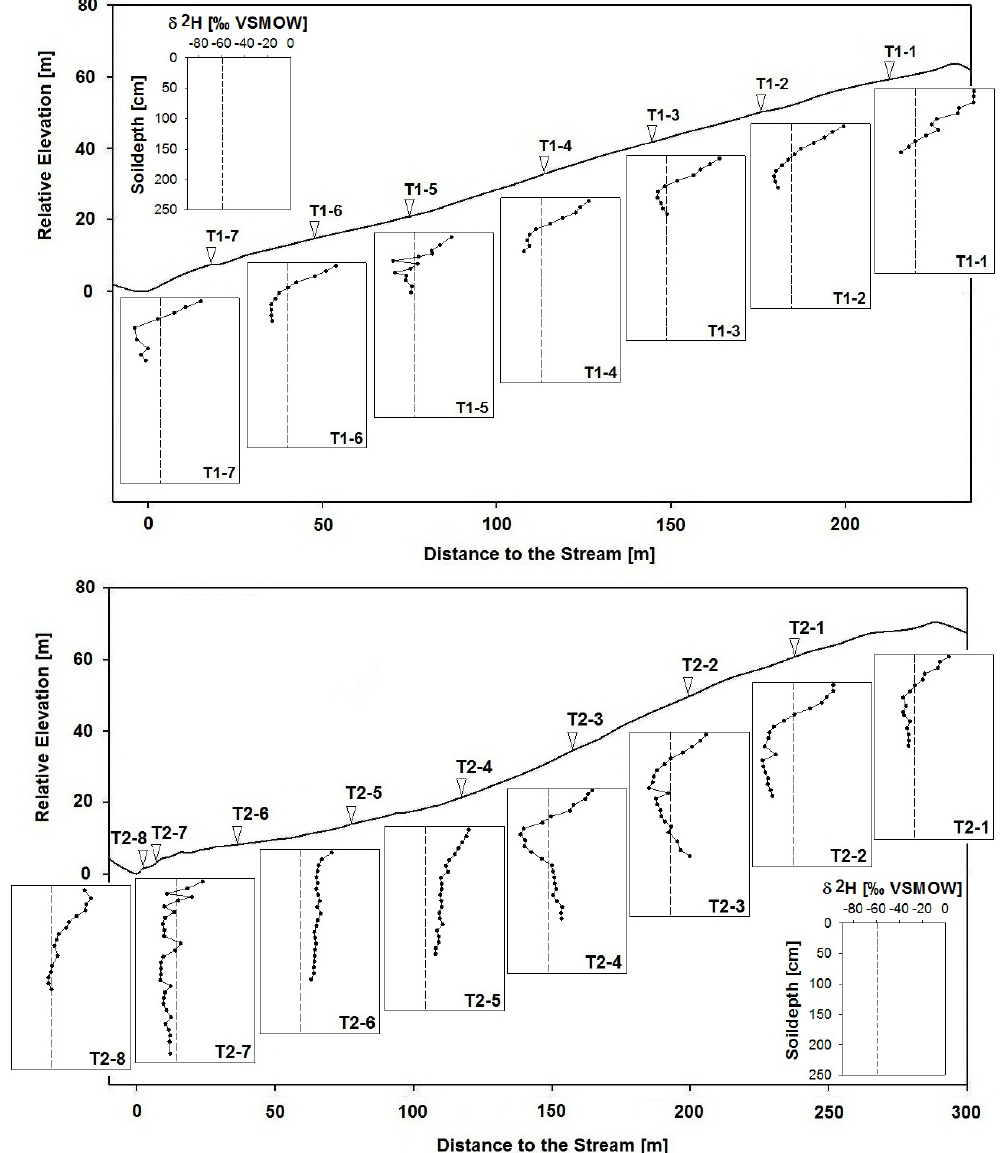
Fig. 4. Longitudinal profile of transect T1 (top) and transect T2 below with the vertical depth deuterium profiles of pore water. There is a reference plot indicating the soil depth and the deuterium values of the profiles in each study hillslope cross-section. The dashed line represents the value of the sampled